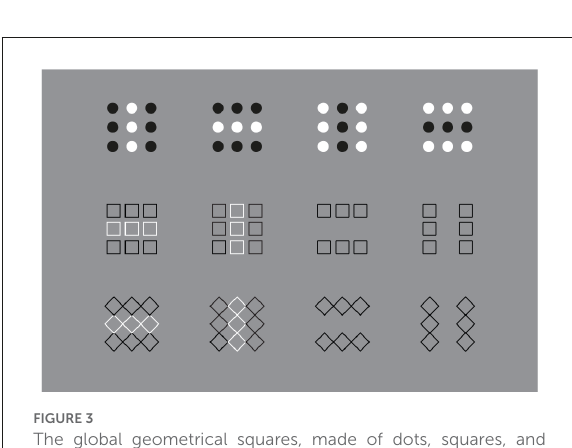
FIGURE3 The global geometrical squares, made of dots, squares, and diamonds, appear as horizontal or vertical rectangles according to their horizontal or vertical grouping due to the similarity or proximity